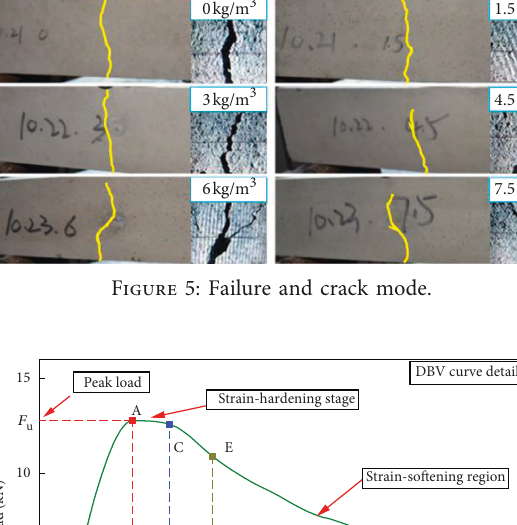
Figure 8: Equivalent flexural strength of DBV-1998.